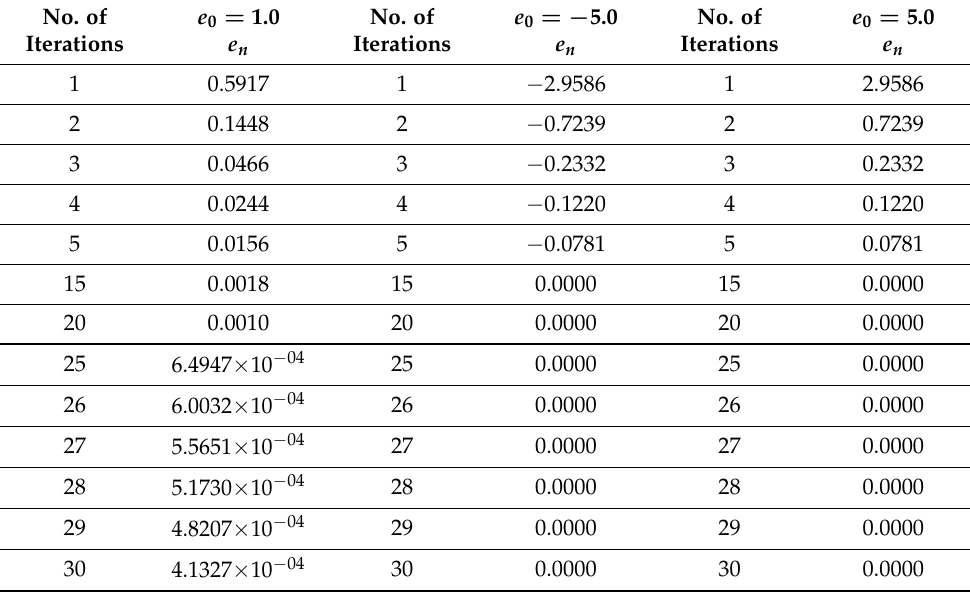
Table 1. Computation outputs for different initial values e 0 = 1, − 5.0 and